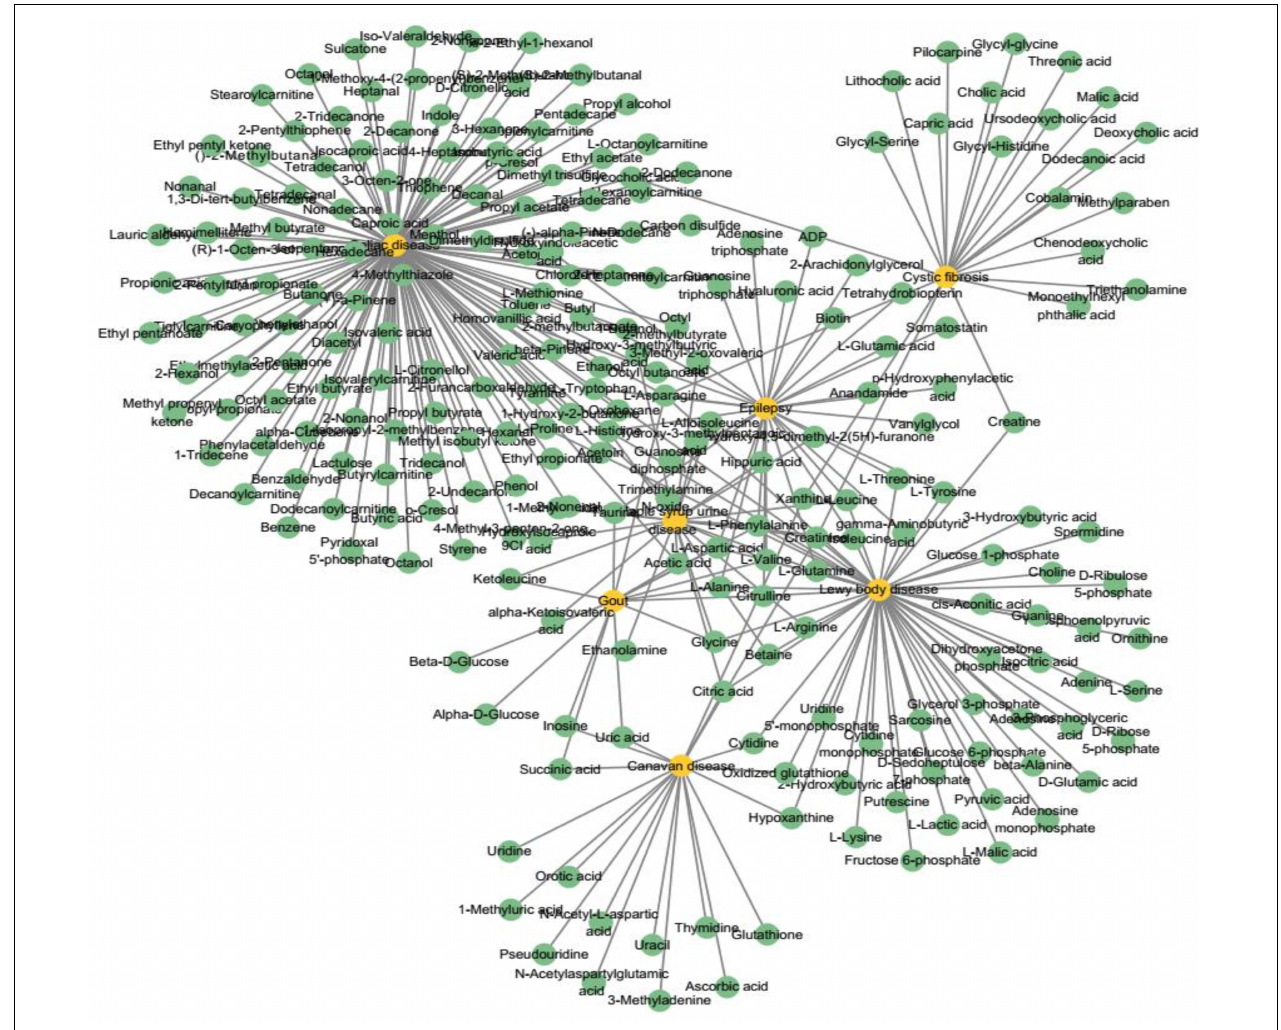
FIGURE 2 | A part of the known metabolite–disease associations network. Yellow nodes represent diseases and green nodes represent metabolites.